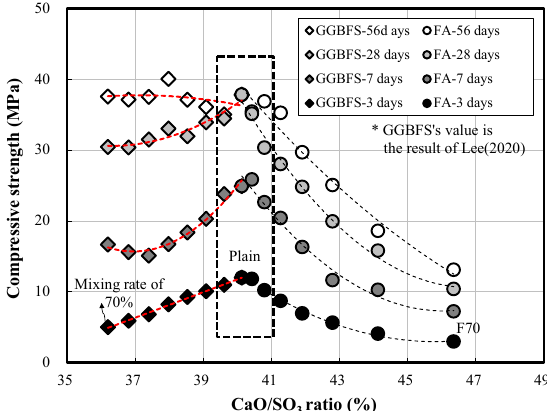
Figure 18. Results of the compressive strength in terms of the CaO/SO 3 rate.